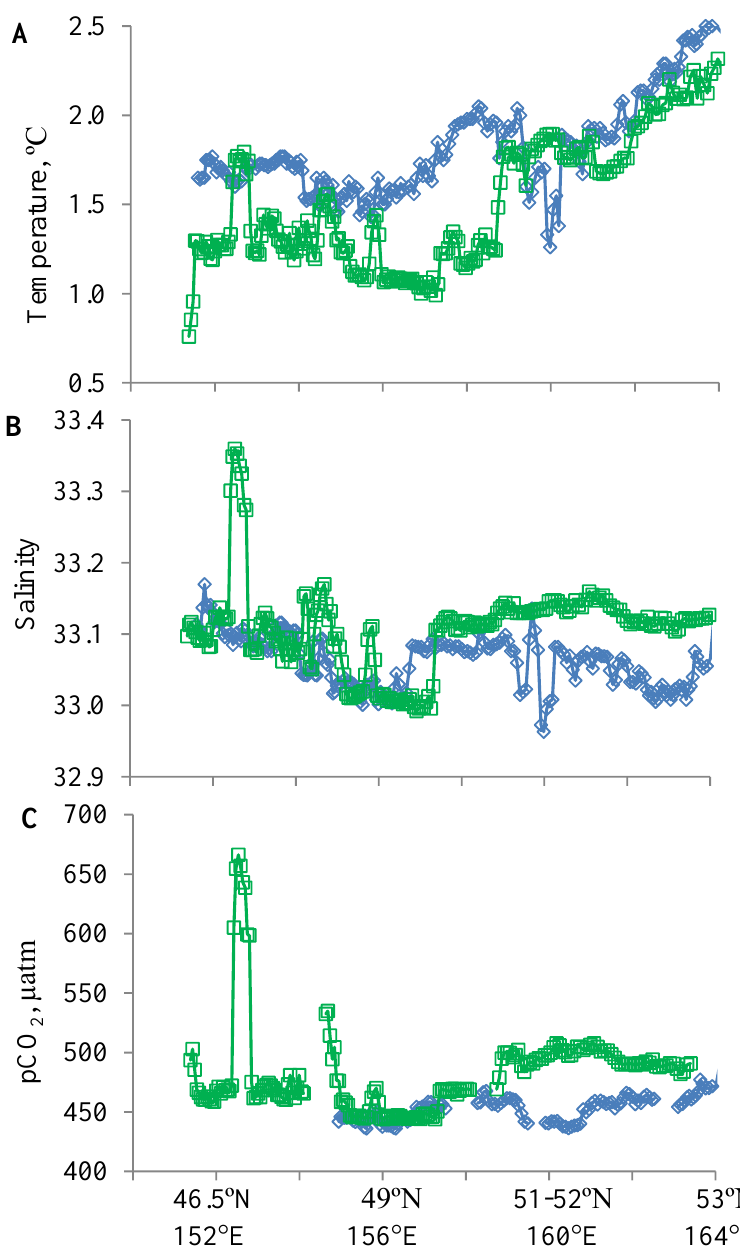
Figure 7. The distribution of the temperature ( A ), salinity ( B ), and pCO 2 ( C ) along the western boundary of the Pacific Subarctic in winter 2018 and winter 2020 (see Figure 2A). Blue diamonds — 01.02. – 03.02.2018, green squares — 28 – 29.02.2020.